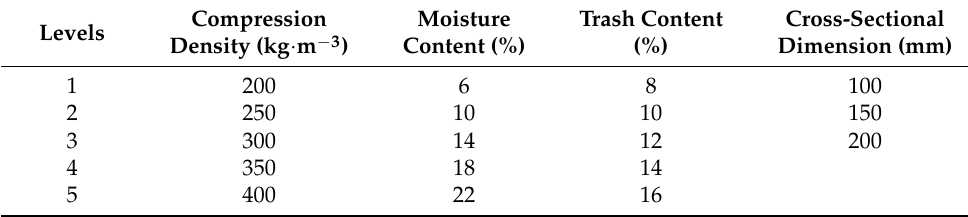
Table 1. The levels of experimental factors.